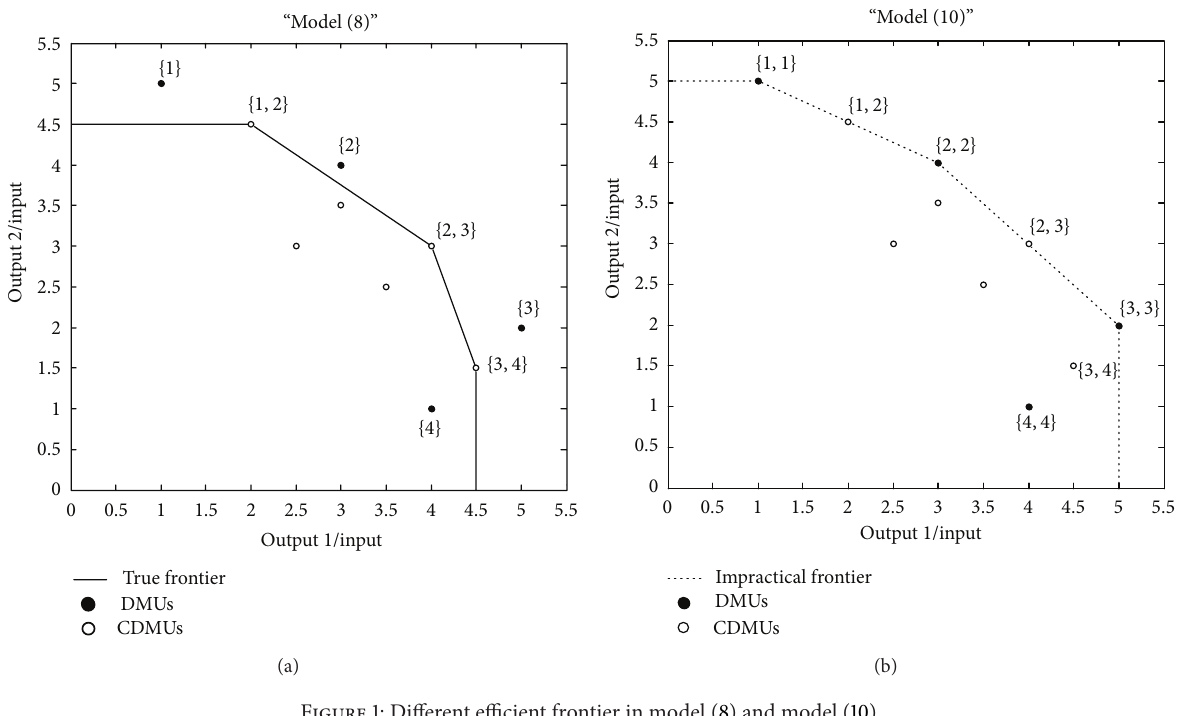
Figure 1: Different efficient frontier in model (8) and model (10).